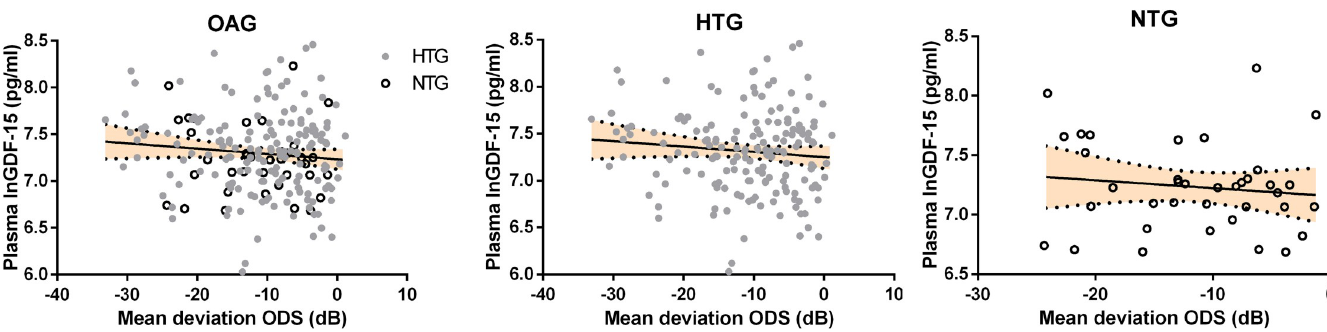
Fig 4. Correlation between plasma GDF-15 concentration (Ln transformed pg/ml) and OAG disease severity. Plasma LnGDF-15 did not correlate with OAG disease severity as assessed by the mean deviation of the average of both eyes (ODS). Neither in the combined OAG population ( β = -0.100; p = 0.159), nor when HTG ( β = -0.099; p = 0.208) and NTG ( β = -0.122; p = 0.470) patients were assessed separately.